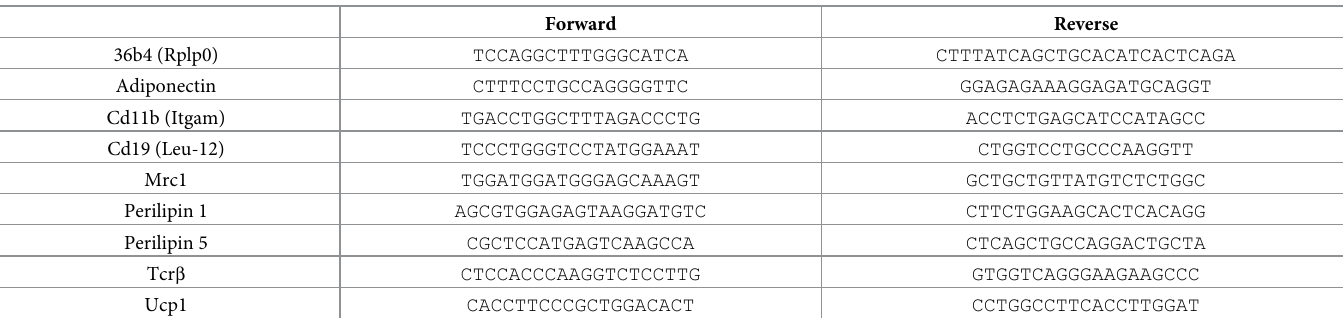
Table 1. Primers sequences used for qPCR